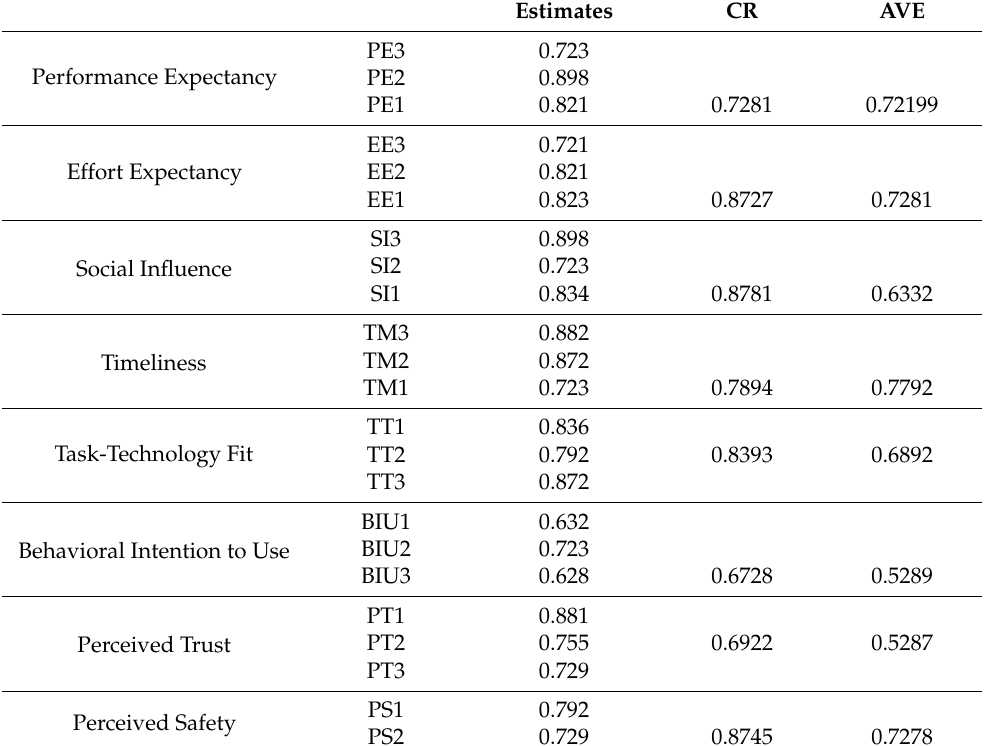
Table 1. Reliability and validity analysis of the